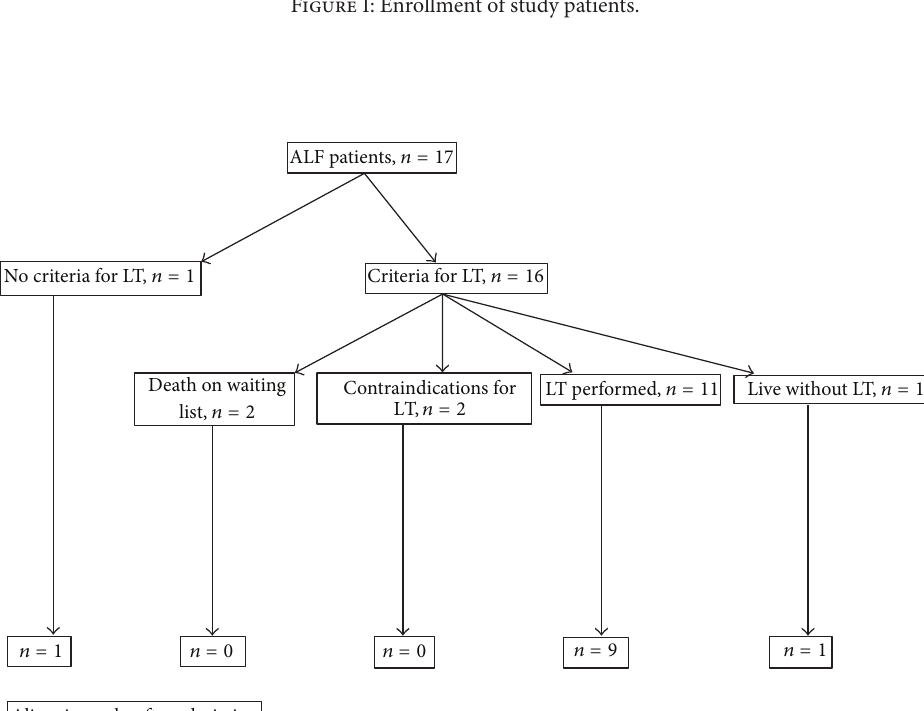
Figure 2: Outcome of 17 patients with acute liver